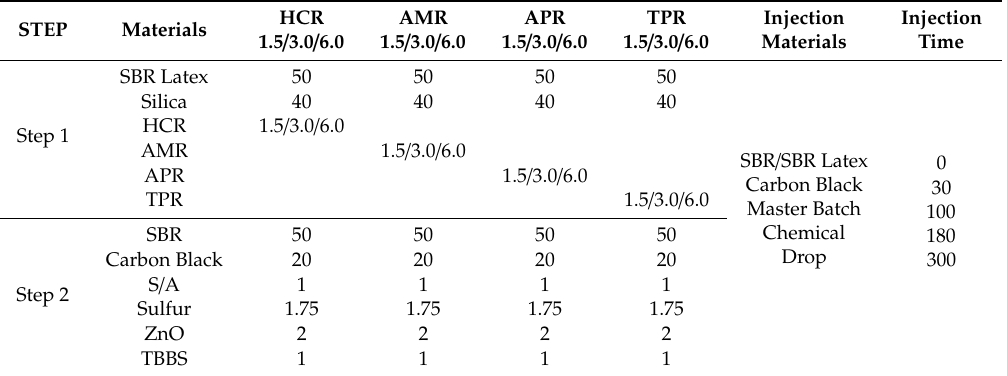
Table 1. Formulation of rubber composites with varying content fractions of di ff erent resins in parts per hundred parts of rubber